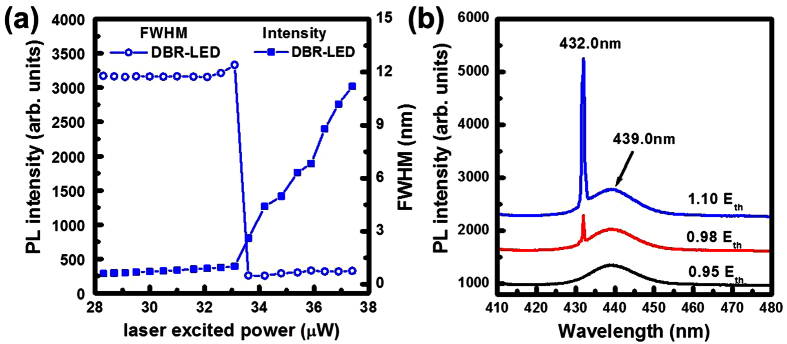
(a) The PL intensities and the linewidth of the optical pumping spectra were measured as a function of the laser excitation power. (b) The emission spectra of the DBR-LED structure were observed under 0.95Eth, 0.98Eth, and 1.10Eth laser pumping power.